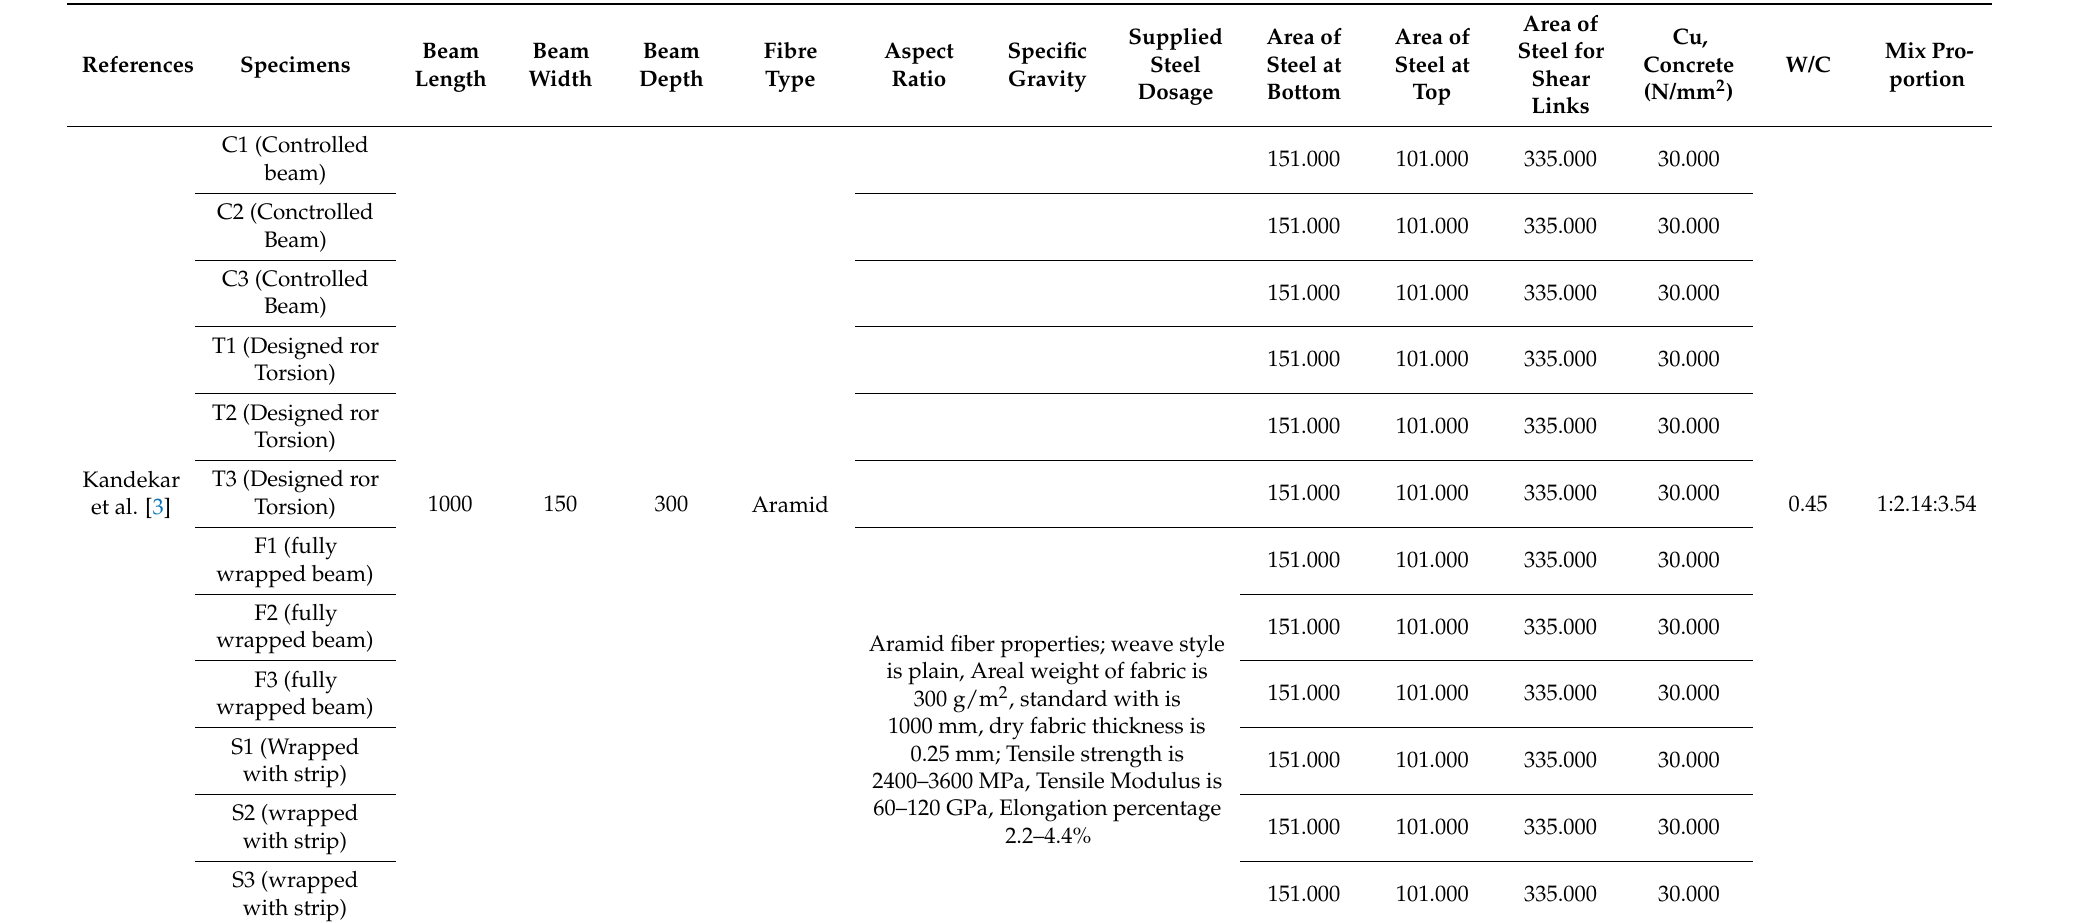
Table 6. Methods of preparation of aramid fibre reinforced concrete from previous